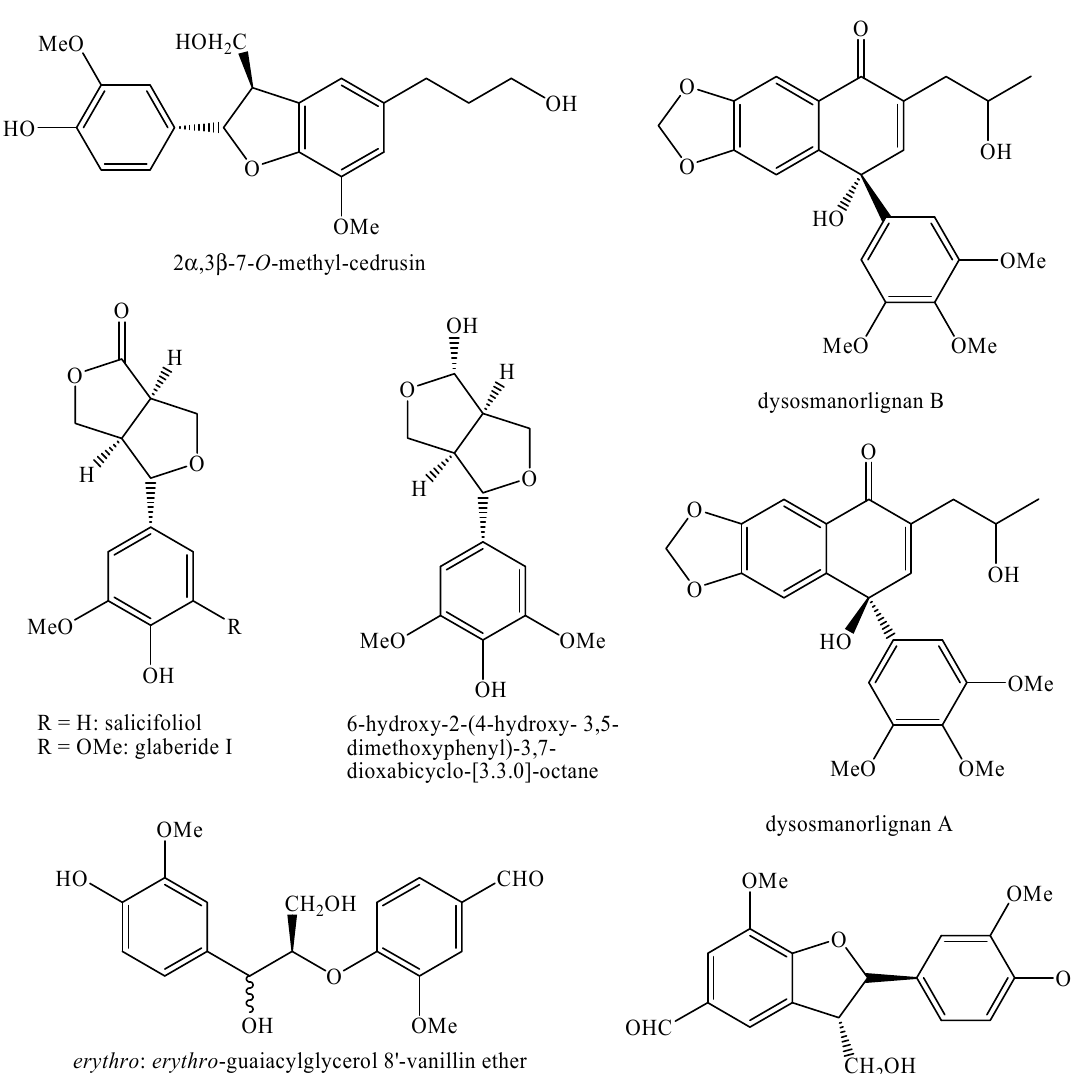
Figure 21. Isolated nor -lignans in the plant kingdom—part 20.